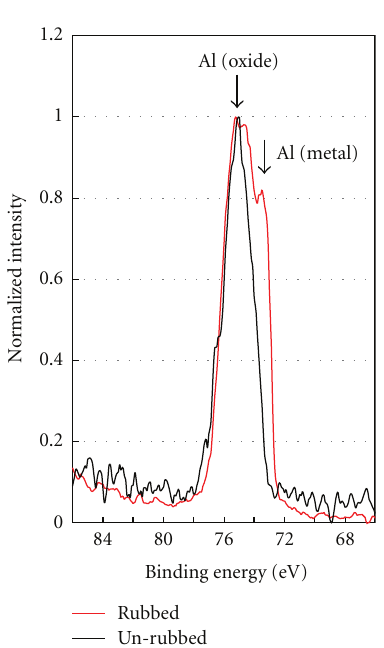
Figure 10: XPS spectrum of rubbed surface: Al 2p (GMO in PAO for 120 min).